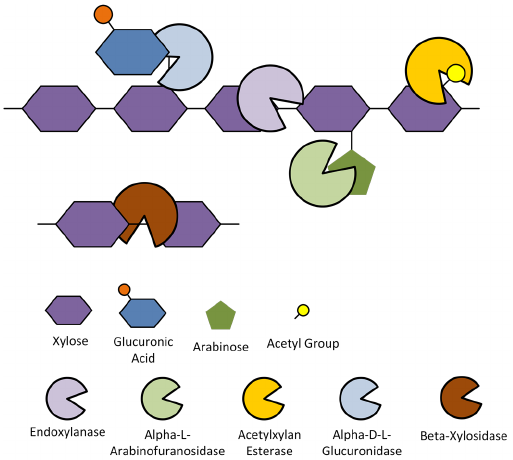
Figure 5. Basic structural component of xylan and the hemicellulases required for the efficient release of xylose from its structure.